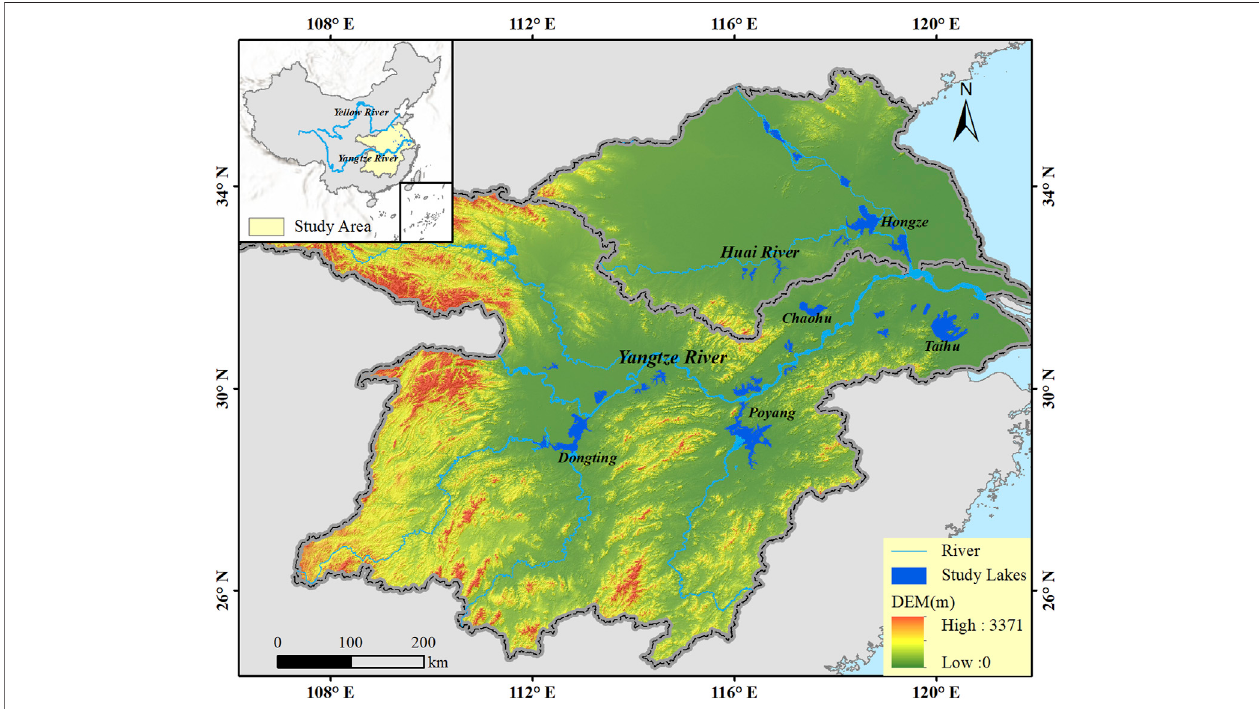
FIGURE 1 | The geographic distribution of the plain lake group (29 studied lakes) in the Yangtze – Huai River Basin (YHRB).